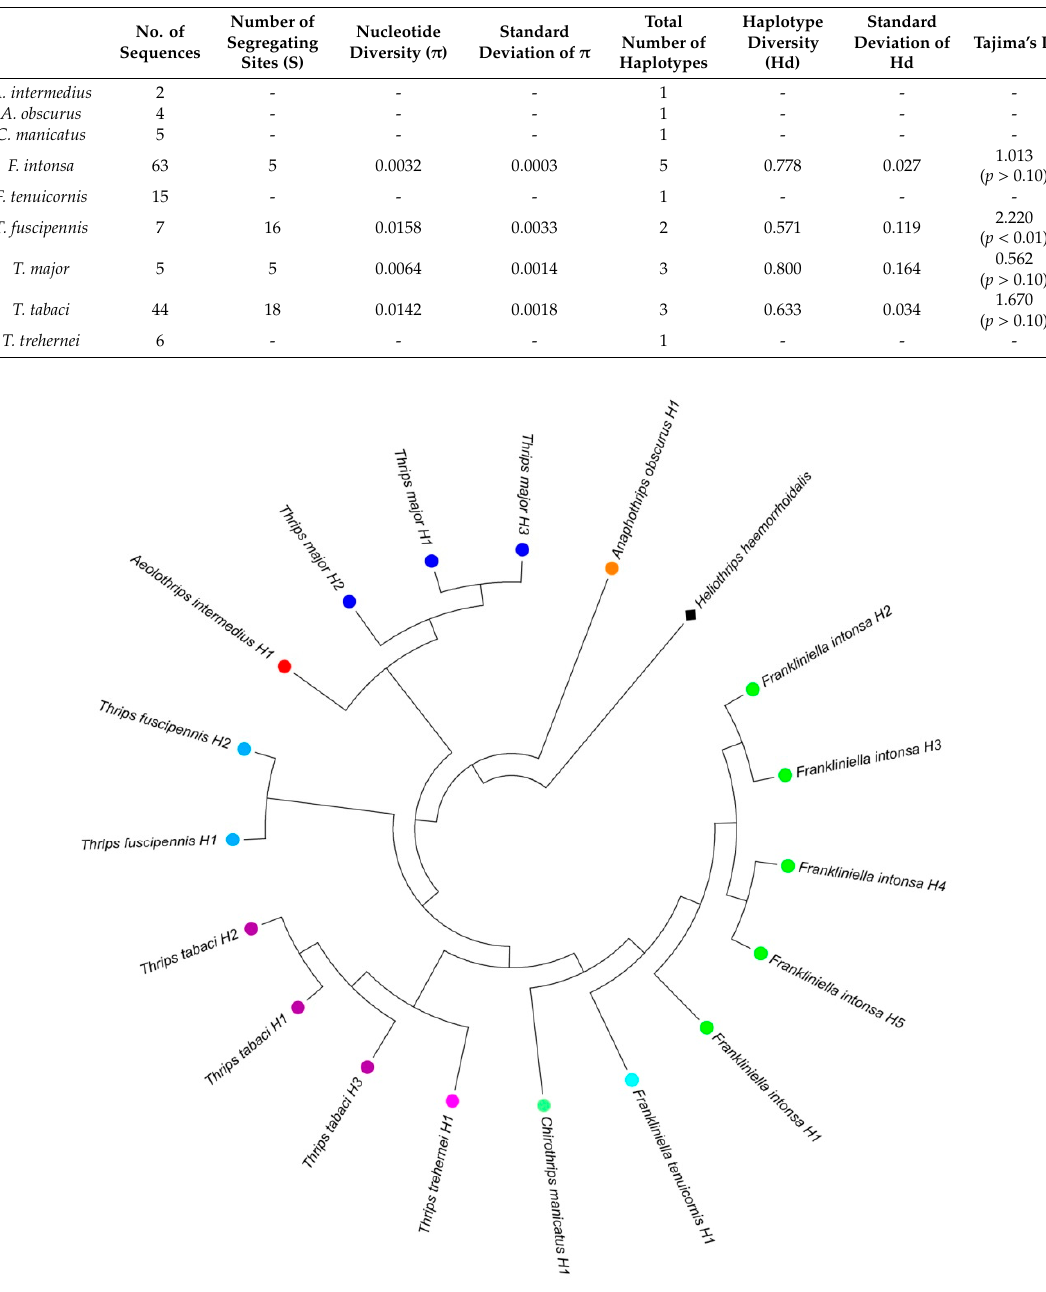
Table 3. Genetic diversity and Tajima’s D evaluated for each detected species.